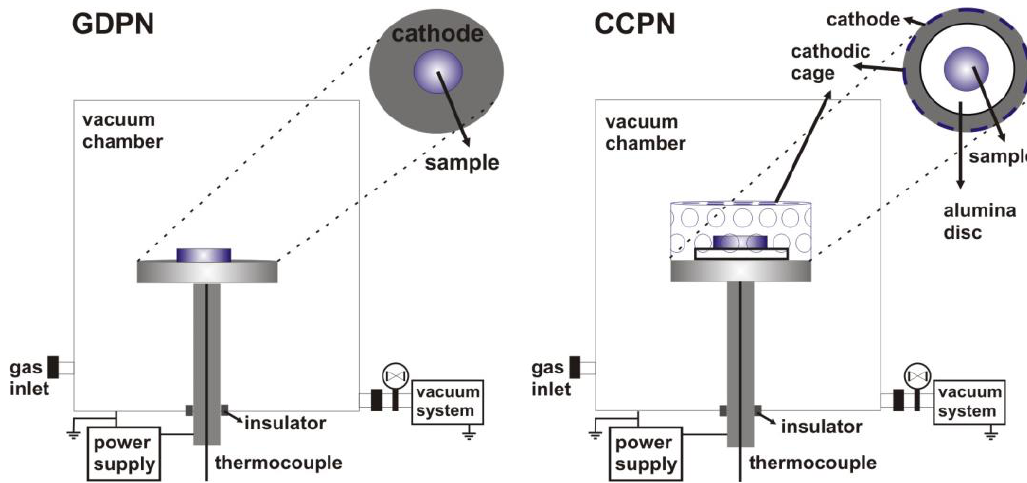
Figure 1. Schematic diagrams for the GDPN and CCPN treatments.